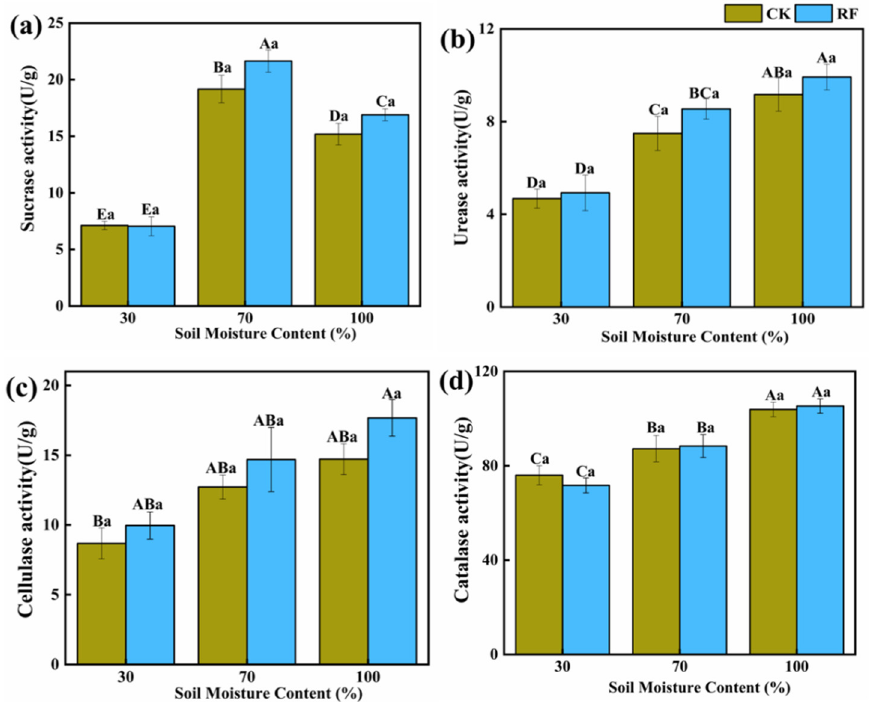
Figure 4. Comparison of soil enzyme activities with RF application at different SMCs: ( a ) sucrase activities; ( b ), urease activities; ( c ), cellulase activities; ( d ), catalase activities (uppercase letters and lowercase letters represent significant differences, as explained in Figure 1).